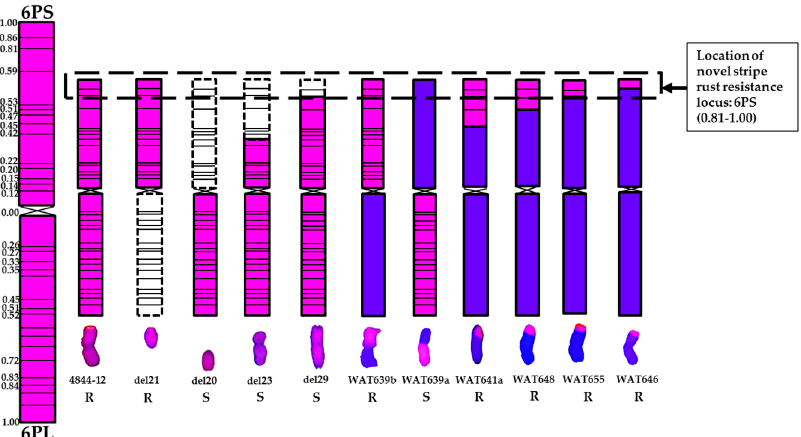
Figure 6. Chromosomal localization of the novel stripe rust resistance locus from A . cristatum 6P and